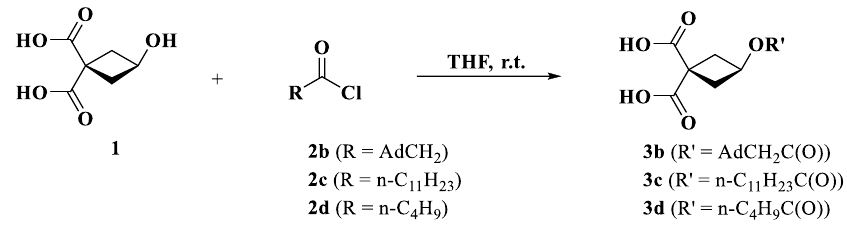
Figure 4. Synthesis of ligands for new platinum complexes.